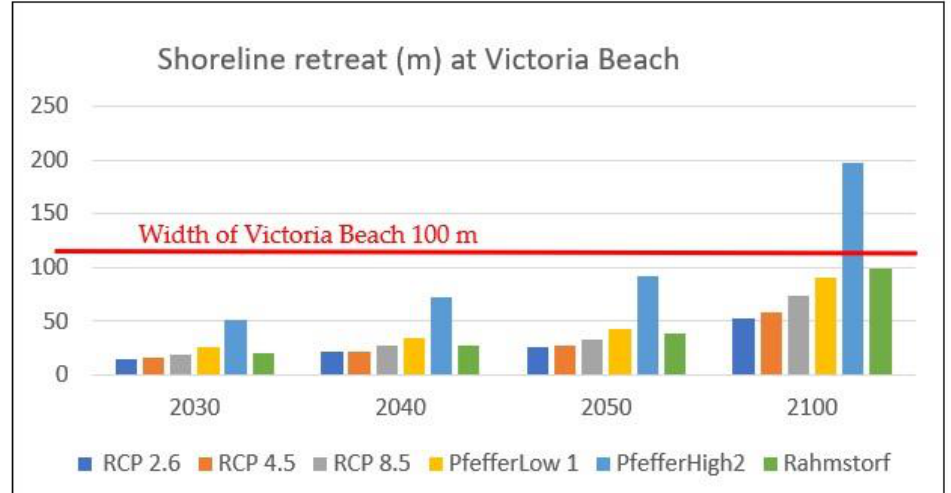
Figure 6. Shoreline retreat (m) at Victoria Beach projected for the years 2030, 2040, 2050, and 2100, according to the different models and scenarios.